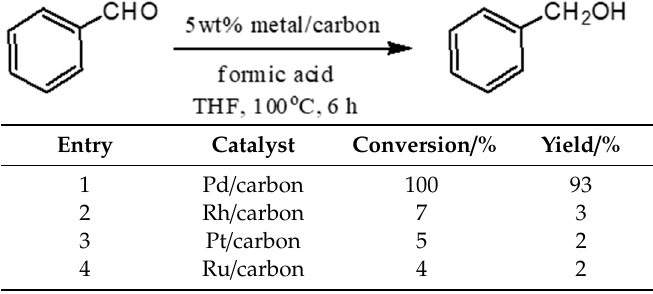
Table 1. Reaction of Benzaldehyde with formic acid using carbon-supported metal catalysts.